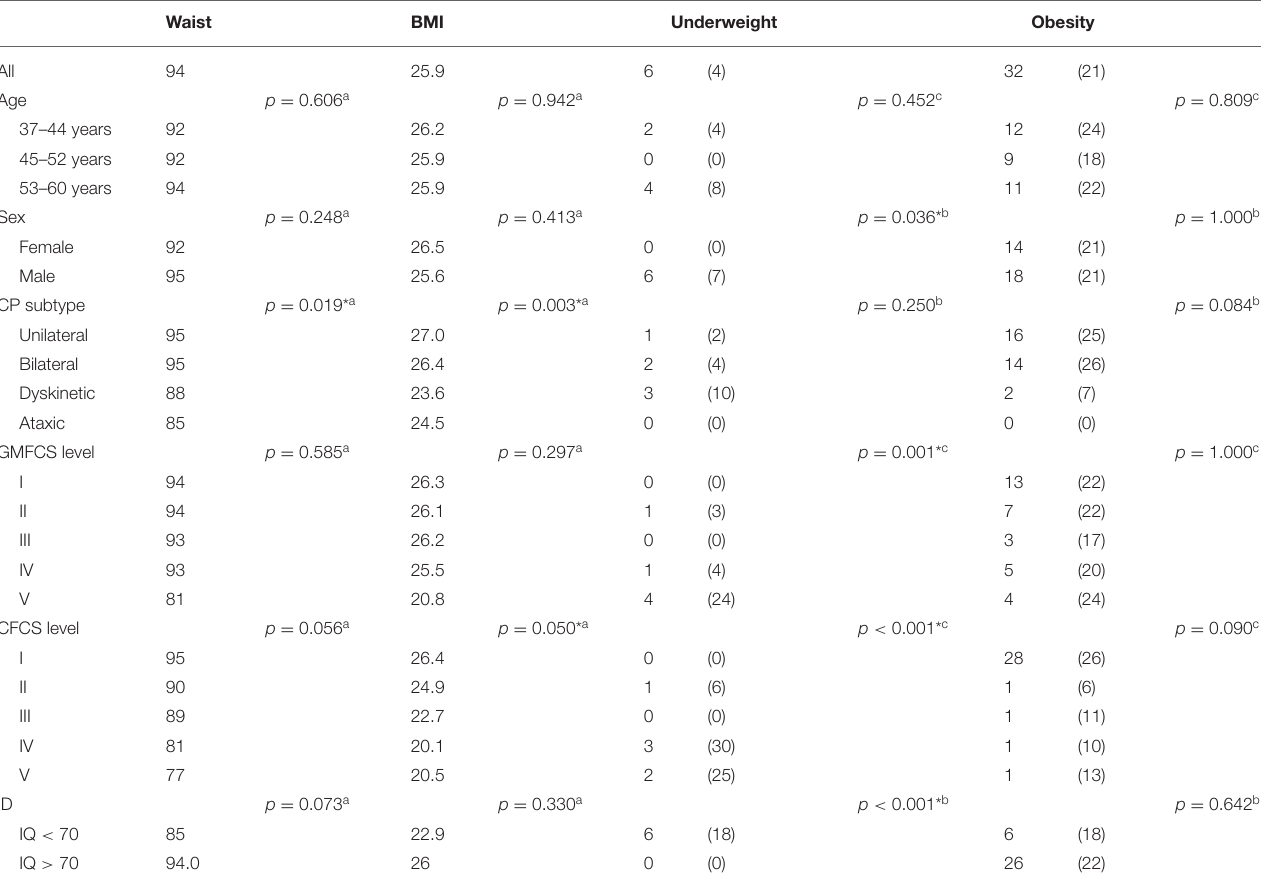
TABLE 4 | Waist and body mass index (BMI) in adults with CP, by age, sex, CP subtype, and impairments ( n = 152). Waist BMI Underweight